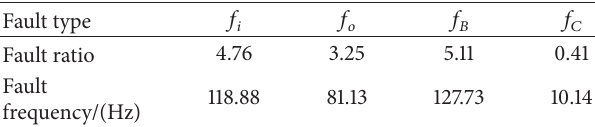
Table 2: Fault characteristic frequencies of the test rolling bearing. 𝑓 outer race (BPFO); 𝑓 𝐵 , ball fault frequency (BFF); 𝑓 𝐶 , cage pass frequency